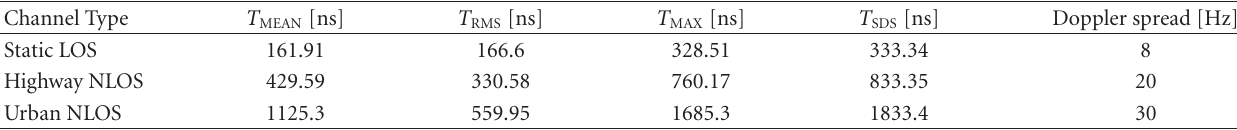
Table 5: OFDM simulation